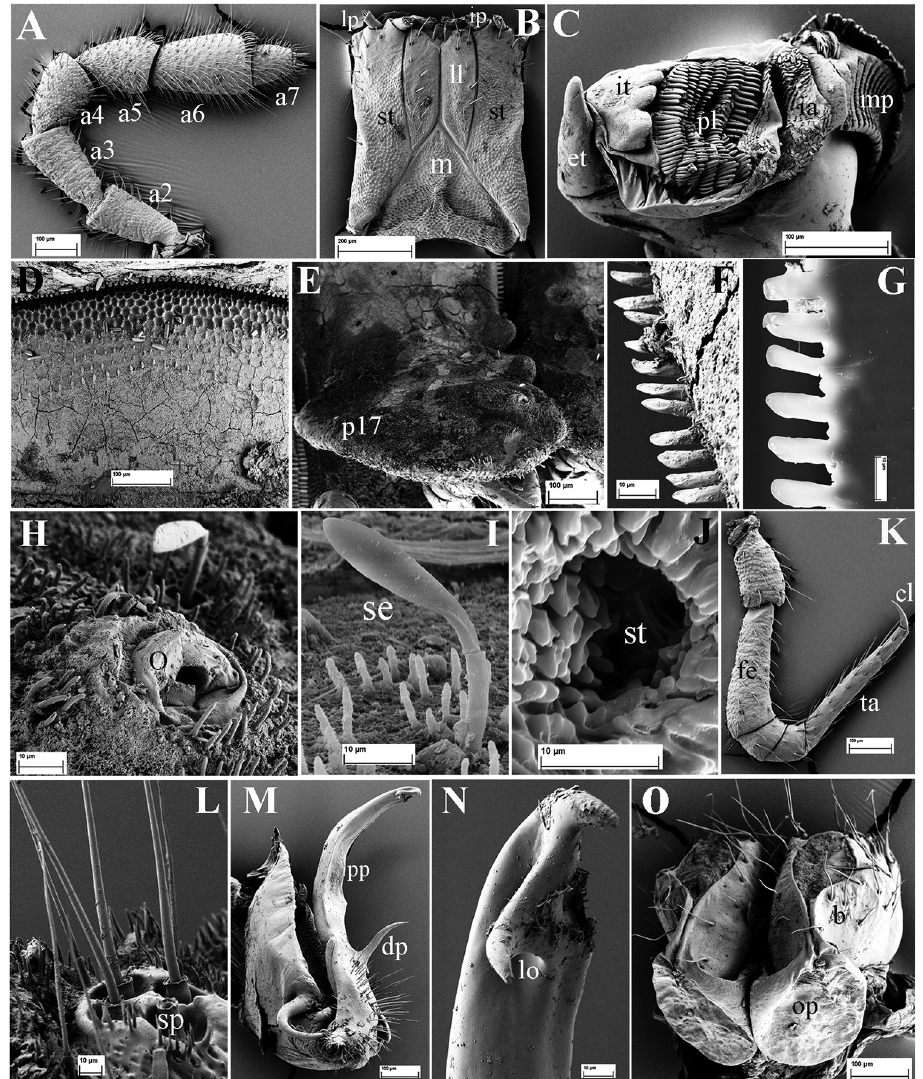
Figure 3. E. steineri sp. n., SEM, male paratype from Cave Tham Deu. A right antenna, lateral view (a2–a7 = antennomeres 2–7) B gnathochilarium, ventral view (lp = lateral palpus; ip = inner palpus; st = stipites; ll = lamellae linguales; m = mentum) C right mandible, general view (et = external tooth; it = internal tooth; pl = pectinate lamellae; ia = intermediate area; mp = molar plate) D prozonum 8, dorsal view E paratergum 17 (p17), lateral view F limbus of metatergum 5, lateral view G endotergum 7 H ozo- pore (o) and a seta of paratergum 17, general view I a seta (se) J stigmata (st) on segment 6, ventral view K midbody leg, frontal view (fe = femur; ta = tarsus; cl = claw) L spinnerets (sp), subventral view M left gonopod, mesal view (dp = distofemoral process; pp = papillate process) N tip of left gonopod, mesal view (lo = lobule) O female paratype, vulvae, general view (op = operculum; b =